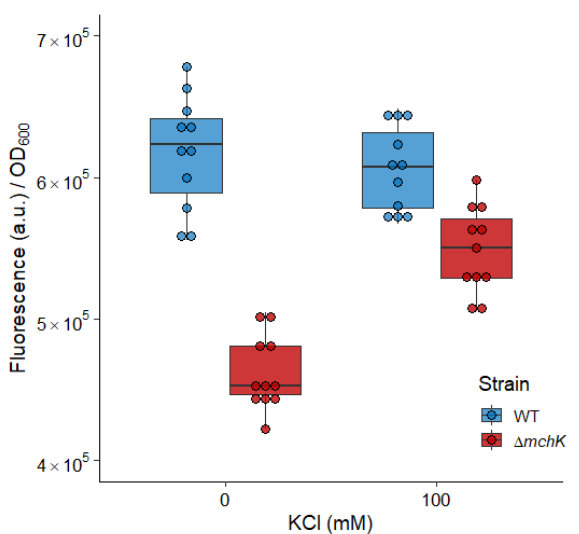
Figure 4. Membrane potential of mc 2 155 and ∆ mchK and effect of K + addition. Cells were pre- incubated for 30 min without or with KCl (100 mM). Fluorescence was measured after 10 min of incubation with rhodamine 123. Dots represent the fluorescence data normalized to the OD 600 of the cells of both wild-type (blue) and mutant (red) strains. Boxplots represent median values (horizontal line in the box). The depth of the box represents the interquartile range (50% of the data), and the whiskers extend to 1.5 times the interquartile range.